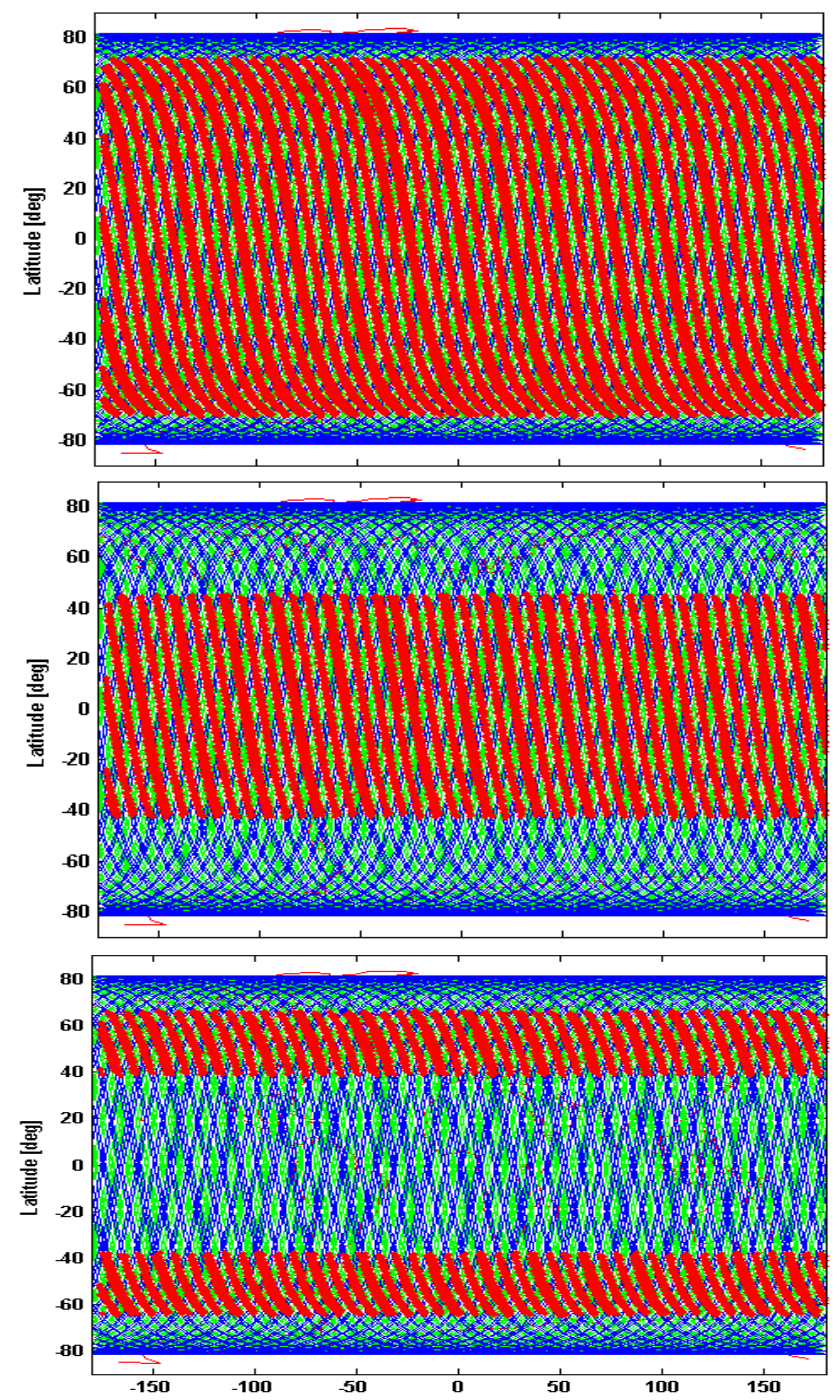
Figure 5. Data acquisition (red dots) for a one week scenario considering a passive system acquiring ASAR signal in WSM (upper panel), ISM4 (central panel) and ISM2 (lower panel). Green/blue lines are the Envisat/passive satellite ground